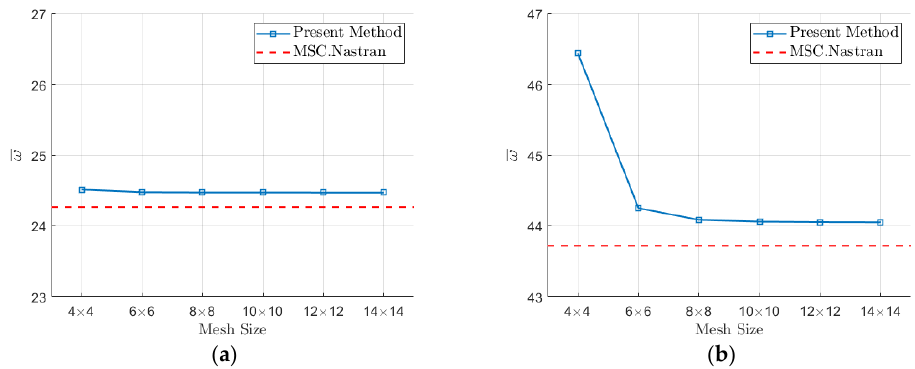
Figure 4. Dimensionless fundamental frequency of the HCS plate with different mesh sizes under ( a ) SSSS; ( b ) CCCC boundary conditions.